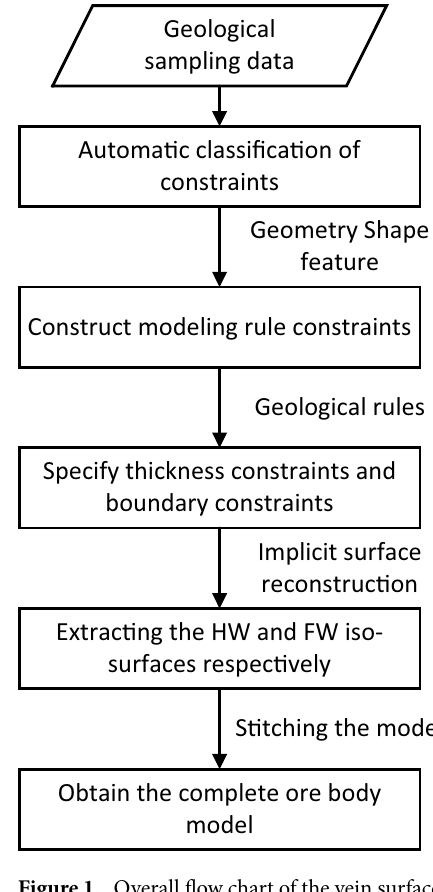
Figure 1. Overall flow chart of the vein surface modeling